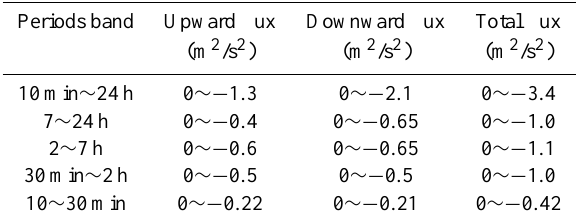
Table 3. The 3rd 24h (most active day) average upward flux and downward flux of zonal momentum in the height 6 ∼ 17km for dif- ferent wave periods